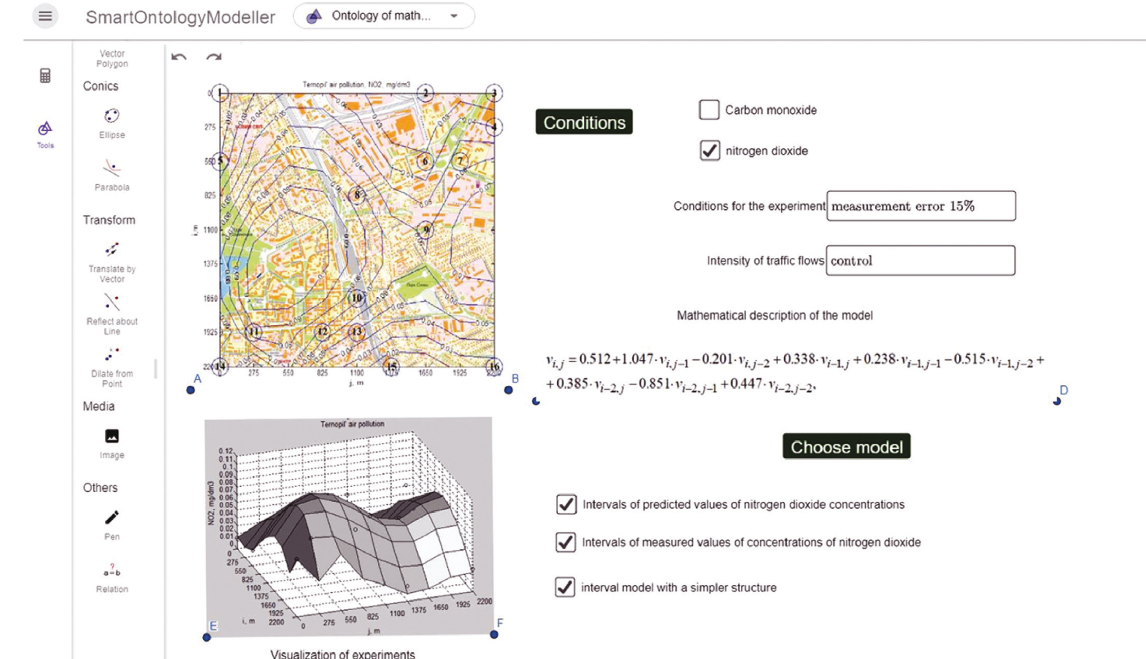
Figure 5: Example of switching the mathematical model depending on the change in control characteristics and conditions of experiments in SmartOntologyModeller